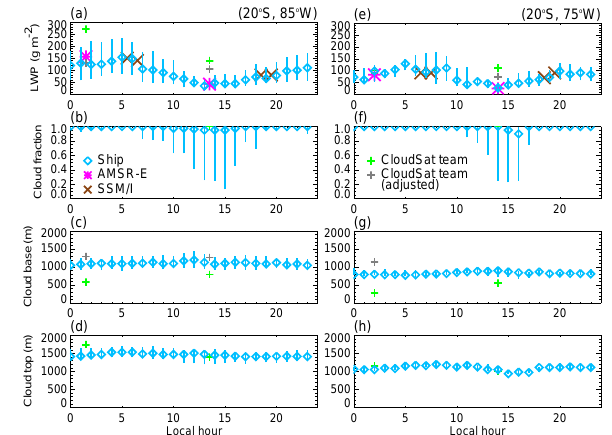
Fig. 3. Median (a, d) LWP, (b, f) cloud fraction, (c,g) cloud base Figure 3. Median (a,d) LWP, (b,f) cloud fraction, (c,g) cloud base height, and (d,h) cloud top height, and (d, h) cloud top height for ∼ 2.8 ◦ latitude (a–d) and lon- height for ~2.8 ° latitude (a-d) and longitude (e-h) bands from the 2001-2007 Stratus cruises gitude (e–h) bands from the 2001–2007 Stratus cruises (with the (with the interquartile ranges indicated by the vertical lines); the CloudSat team products with interquartile ranges indicated by the vertical lines); the CloudSat LWPs adjusted to remove suspected precipitation contamination and based upon adiabatic team products with LWPs adjusted to remove suspected precipita- cloud bases derived from thicknesses from Eq. (1) also shown; and AMSR-E and SSM/I for tion contamination and based upon adiabatic cloud bases derived LWP only. from thicknesses from Eq. (1) also shown; and AMSR-E and SSM/I for LWP only.